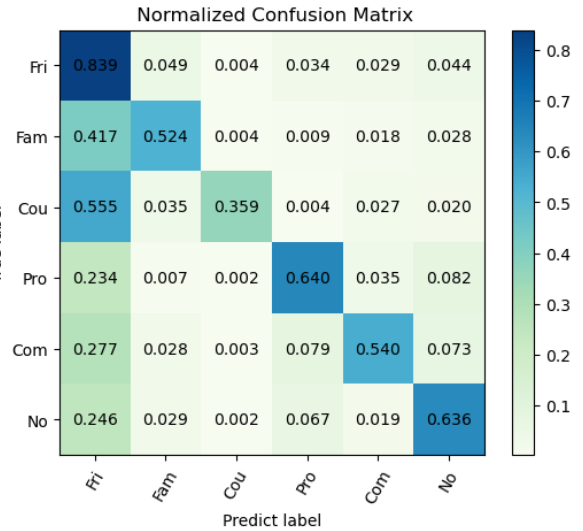
Figure 3. Confusion matrix in the PISC-Fine task. The values from the upper left corner to the lower right corner on the diagonal represent the per-class recall.